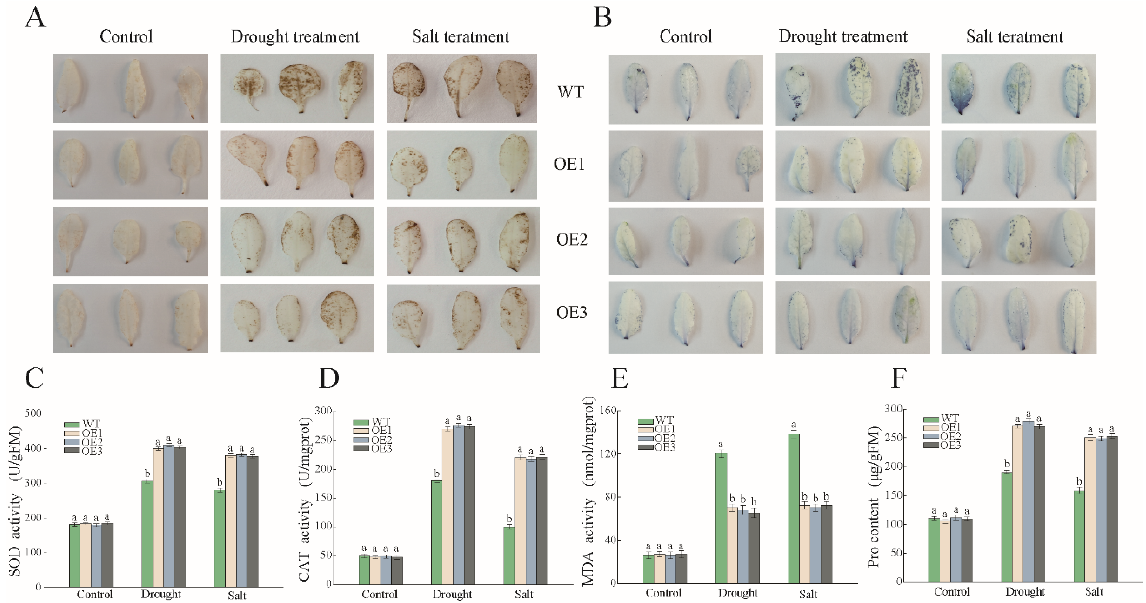
Figure 8. Drought and salt-induced changes in ROS elimination in WT and OE plants. ( A ) In vivo DAB staining to detect H 2 O 2 content. ( B ) In vivo NBT staining to detect the content of O 2 ( C ) SOD activity. ( D ) CAT activity. ( E ) MDA activity. ( F ) Proline content. The significantly different mean values at p ≤ 0.05 were labeled by different letters.